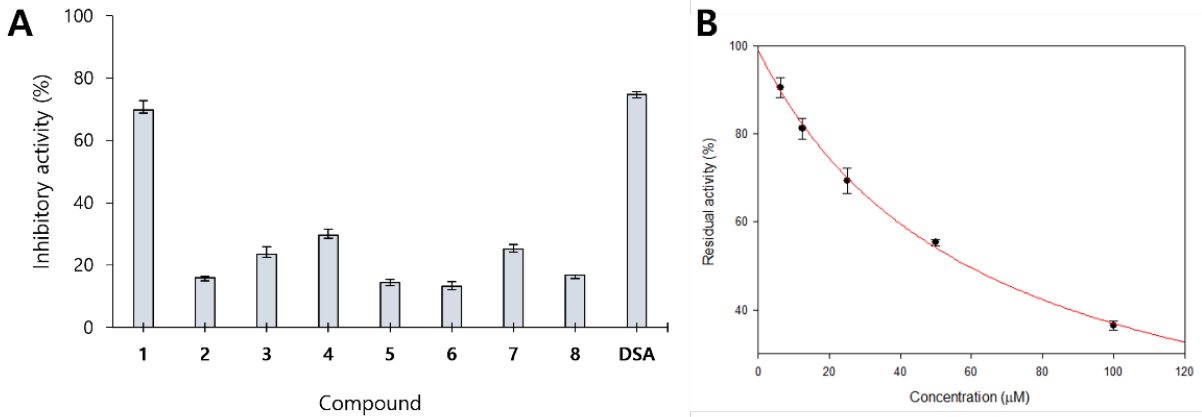
Figure 2. Inhibitory activity of isolated compounds 1 − 8 at 100 µM ( A ) and determination of IC 50 value by compound 1 on β -glucuronidase ( B ).